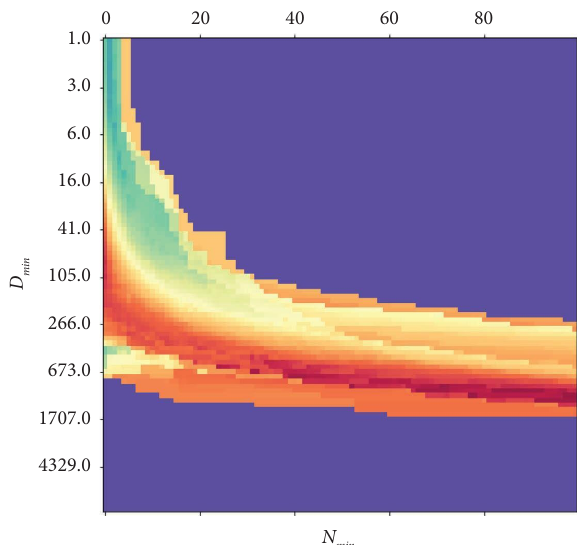
Figure 4: Te distribution of silhouette coefcient of business and company POI clustering results under diferent parameter com- binations. Te colors represent the value of the silhouette coef- cient of the clustering results. Te horizontal axis is the minimum number of clusters N min, and the vertical axis is the neighborhood distance threshold D min . Considering the realistic need for spatial clustering, the units of D min are